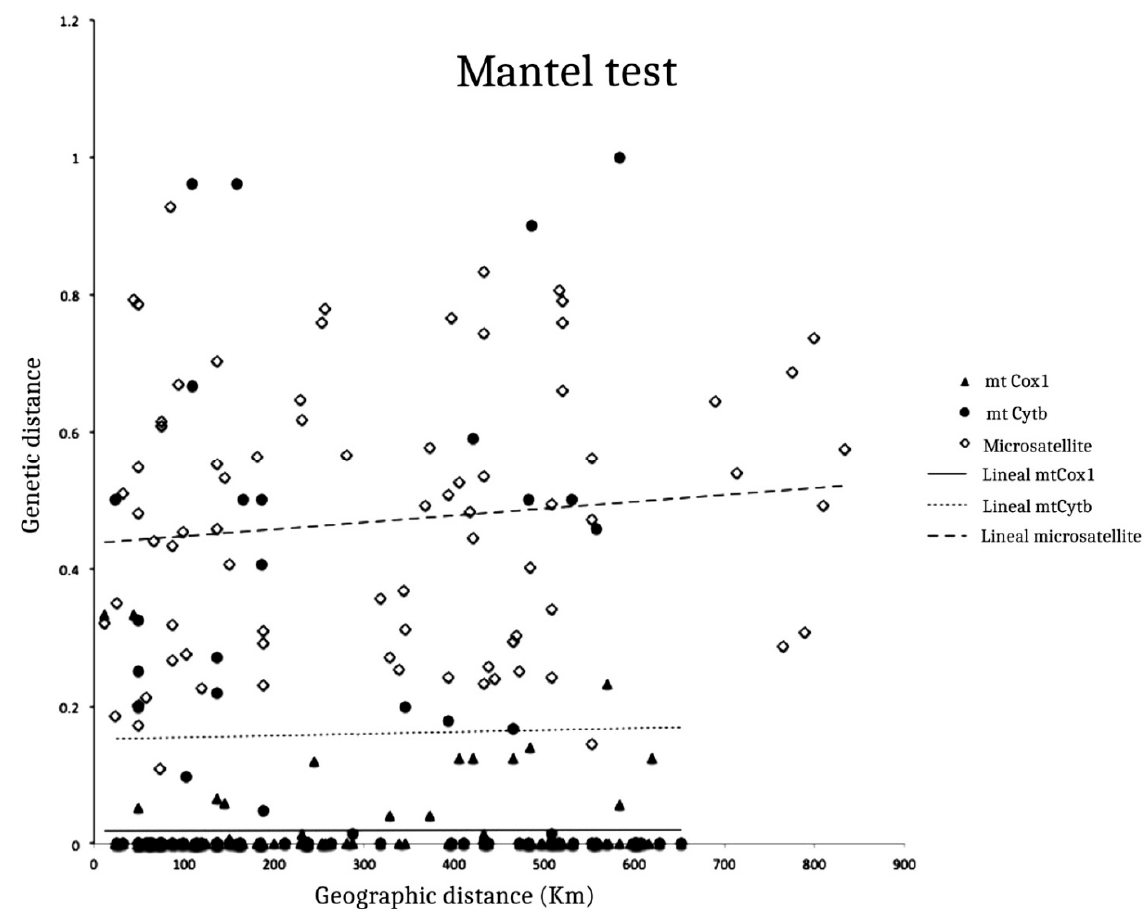
Figure 4. Mantel test. Correlation between genetic distance via Slatkin’s linearized method and the geographic distance (km), including the three markers (mtCox1, mtCytb and microsatellites). R 2 = 0.005 ( p = 0.4265) for mtCox1; R 2 = 0.0478 ( p = 0.3916) for mtCytb and R 2 = 0.1143 ( p = 0.1668) for microsatellites. The dotted line corresponds to the adjusted mtCytb data, the solid line corresponds to the mtCox1 data and dashed line corresponds to the adjusted microsatellite data.